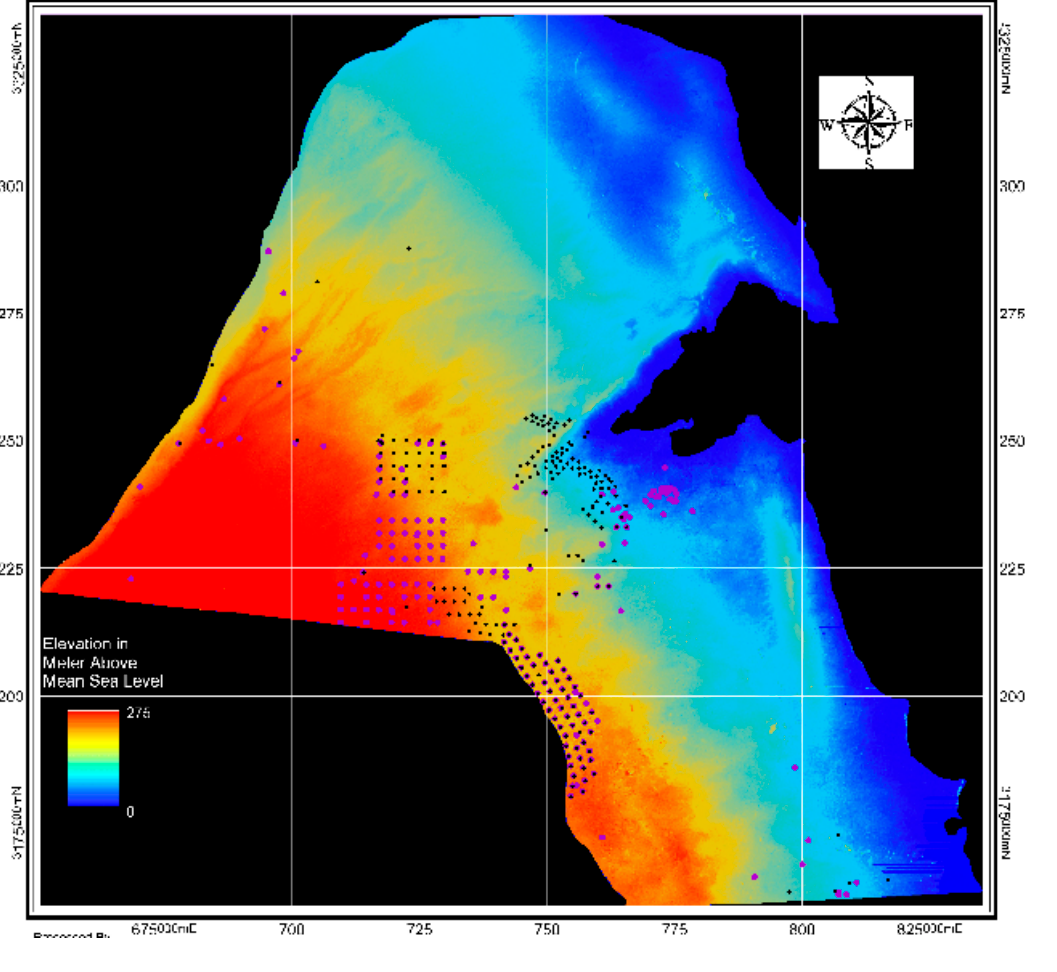
Figure 3. Surface elevation map of the Kuwait Group (Kg) aquifer and spatial location of the transmissivity (T) values for Dammam (Dm) (magenta) and Kg (dark blue) aquifers. The two units of Kg aquifer (upper and lower) are considered as one hydrostratigraphic unit for